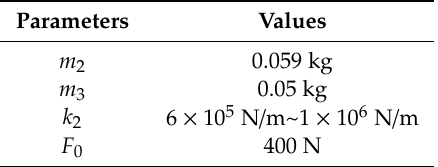
Table 5. The parameters of the system.